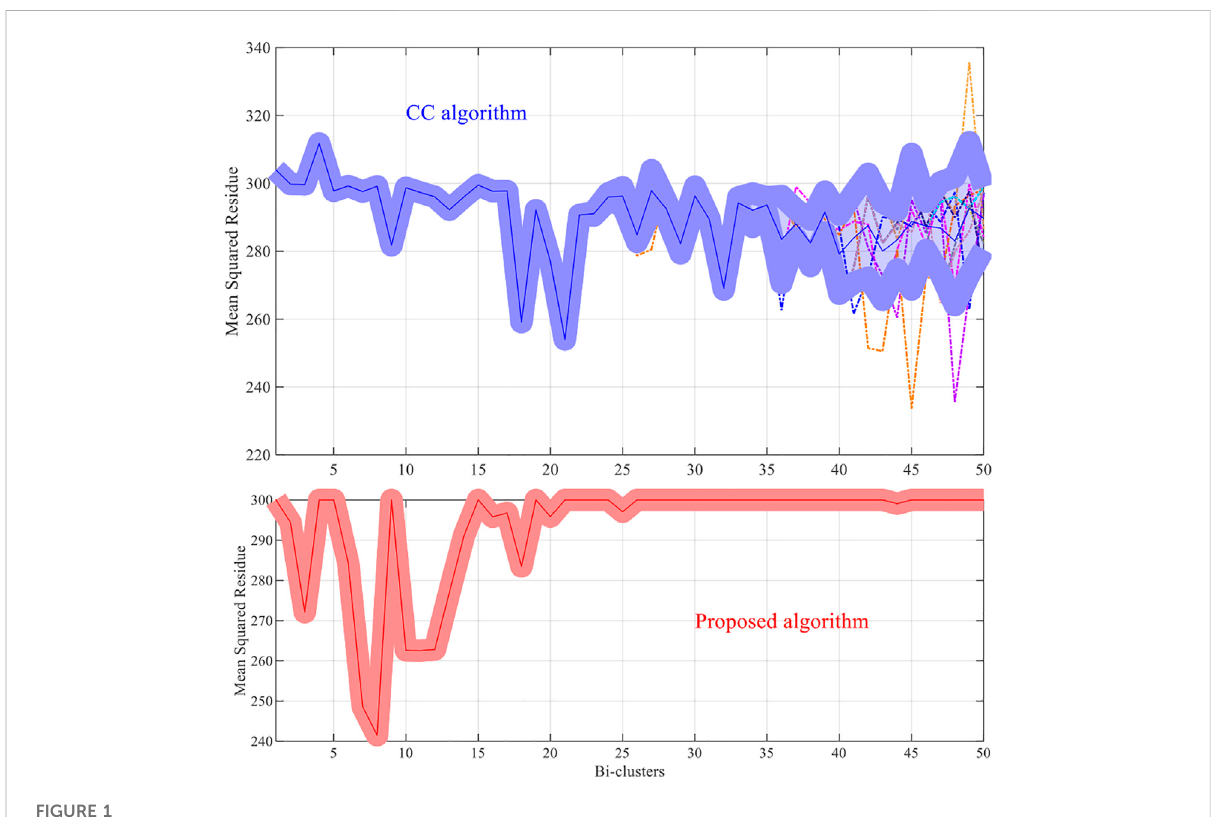
FIGURE 1 Results of the MSR scores of the yeast